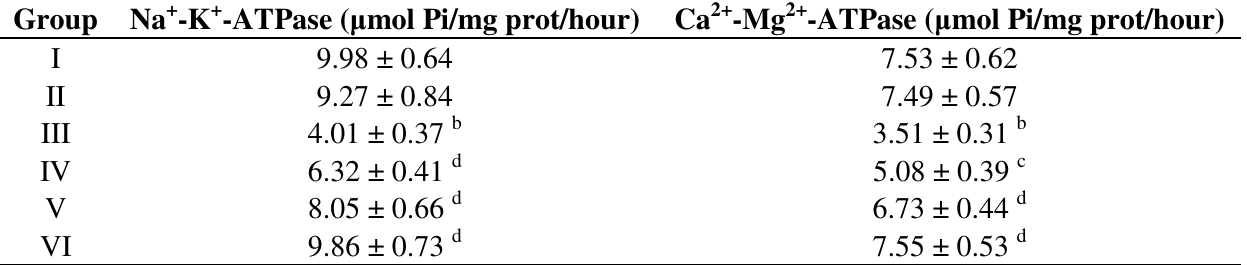
Table 4. Effect of GBE50 on myocardium Na + -K + -ATPase and Ca 2+ -Mg 2+ -ATPase activities in rats.